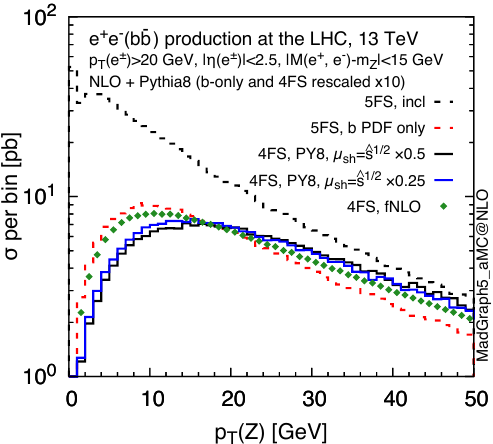
Figure 9 . Comparison of the p ‘ + ‘ (cid:0) distribution in the plain 5FS with the contribution associated ? to the bottom quark, the latter evaluated in di(cid:11)erent schemes and